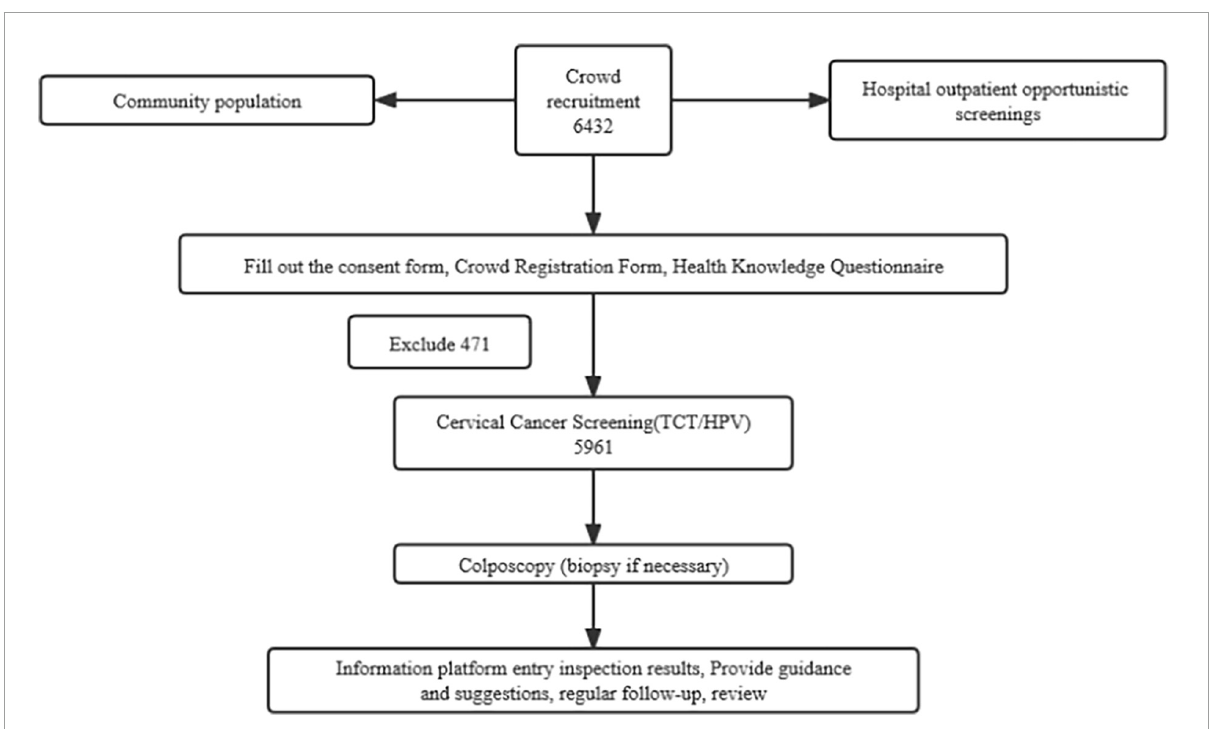
FIGURE1 The CONSORT flow of study.